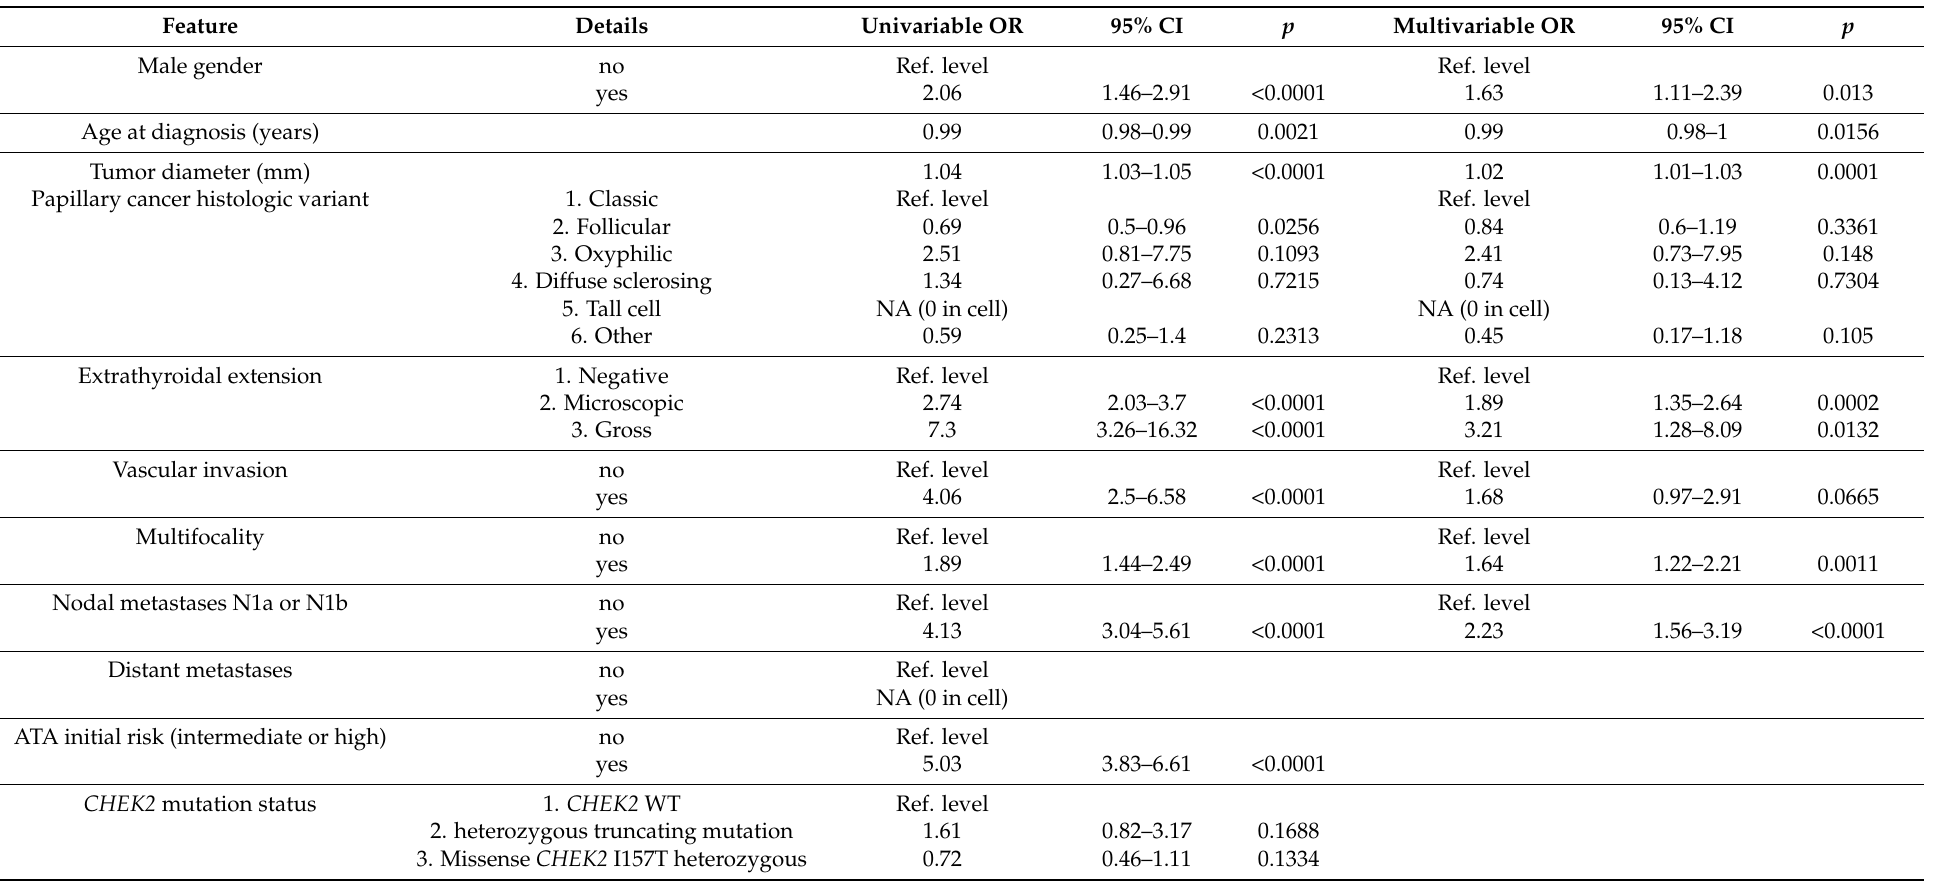
Table 5. Risk factors for non-excellent response (indeterminate, biochemically and structurally incomplete) to initial